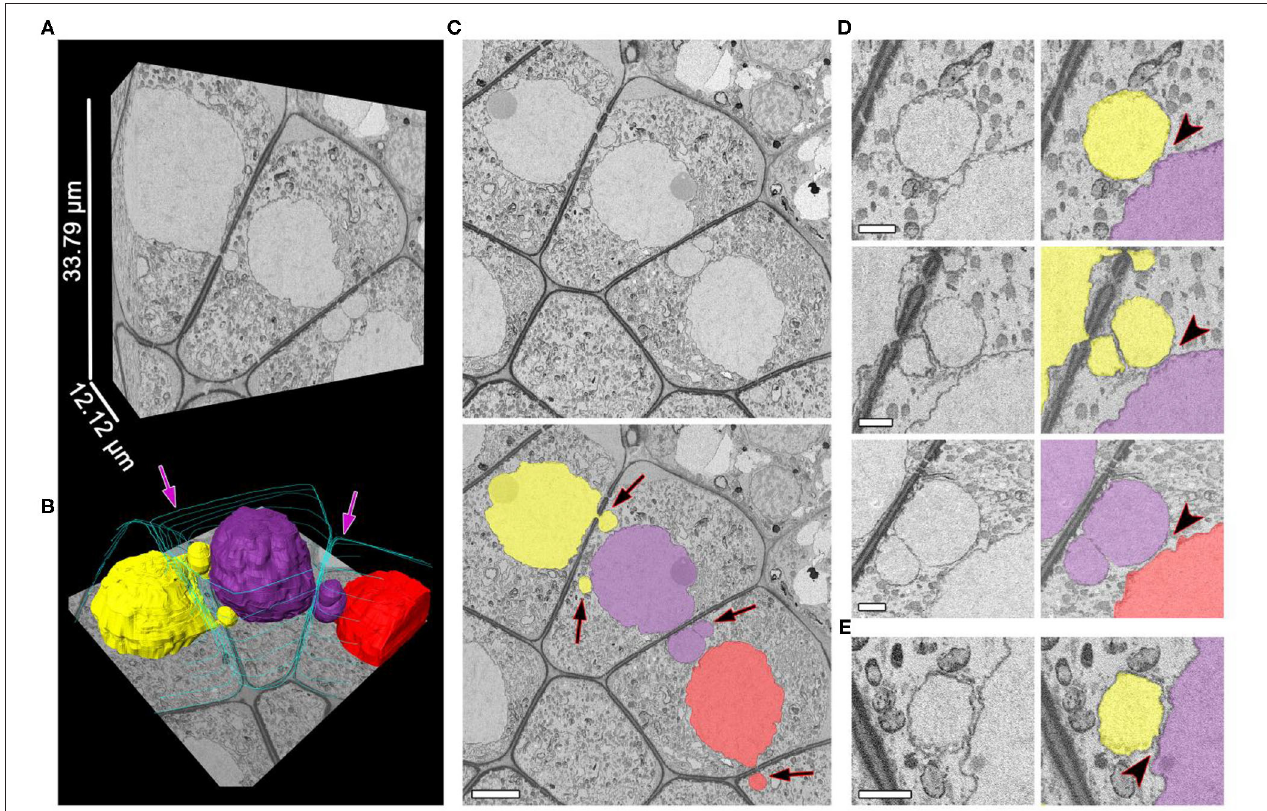
FIGURE 3 | Unidirectional migration of nuclei between meiocytes at zygotene. (A,B) Three-dimensional reconstructions of the scanned tissue fragment by means of 303 serial images. The whole unlabeled tissue fragment (A) and labeled nuclei and cell walls (B) . (C) The original and labeled micrograph. (D,E) Nucleus–nucleus contacts between NPs and nuclei of the neighboring cells, enlarged. The space between nuclear membranes is visible in (D) and not visible in (E) . Yellow, purple, and red denote individual nuclei (all of them are involved in the INM), and turquoise indicates cell walls, labeled on every 50th slice; the arrows indicate the NPs crossing a cell wall; the arrowheads point to nucleus–nucleus contact areas. Scale bars are 5 µ m in (B) and 1 µ m in (D,E)